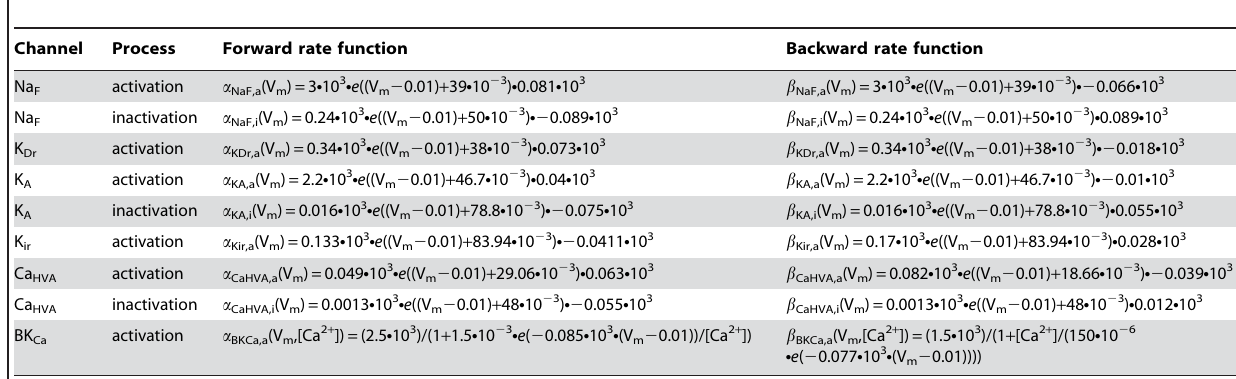
Table 2 . Forward and backward rate functions for different ion channel types in the stochastic model (see Equation 8).